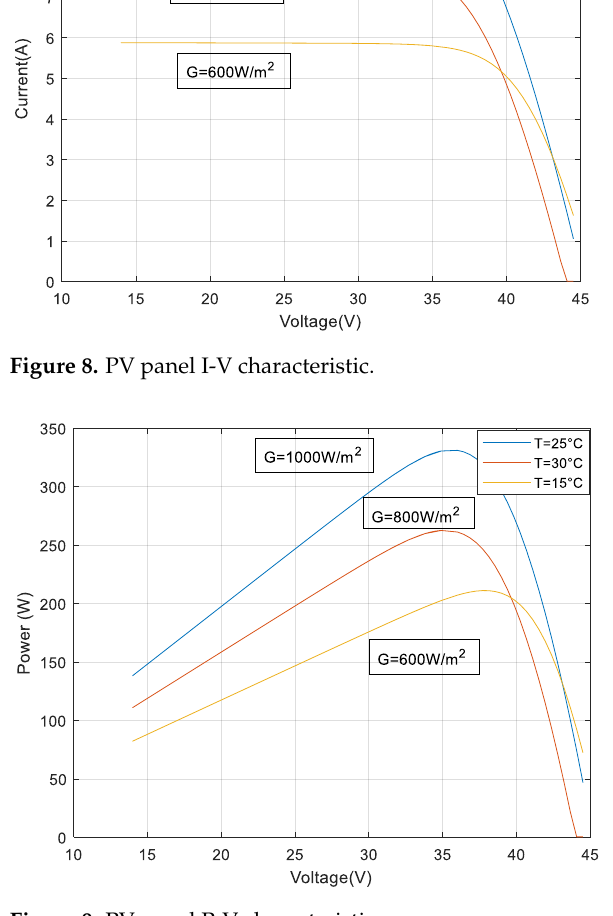
Figure 9. PV panel P-V characteristic.